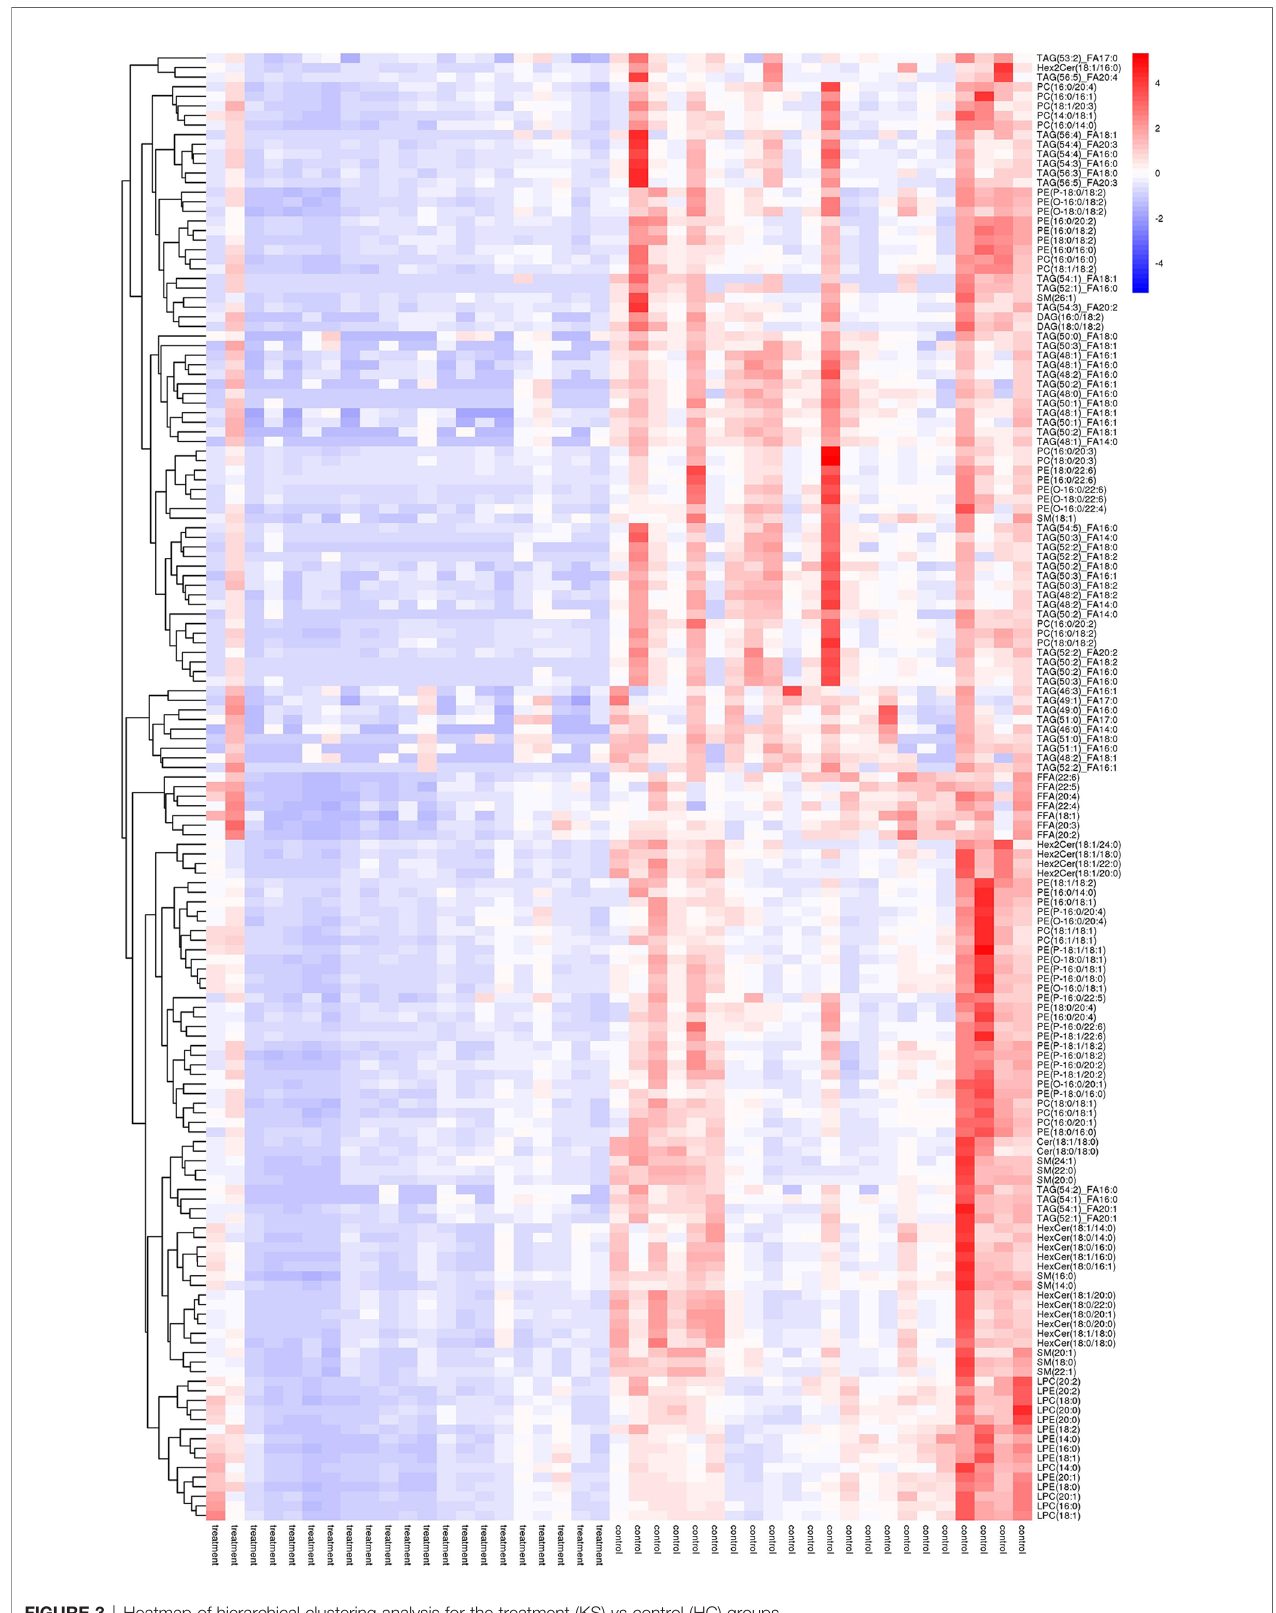
FIGURE 3 | Heatmap of hierarchical clustering analysis for the treatment (KS) vs control (HC)